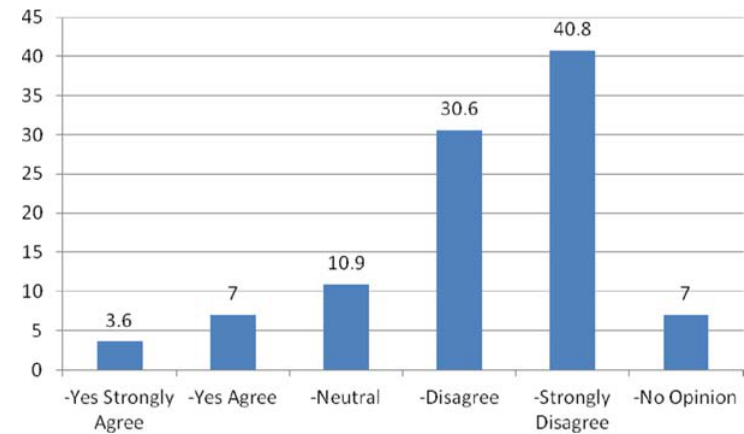
FIG. 5. RESPONDENTS SATISFACTION REGARDING EXISTING PRACTICES OF LAND USES AND ITS DEVELOPMENT OF QASIMABAD